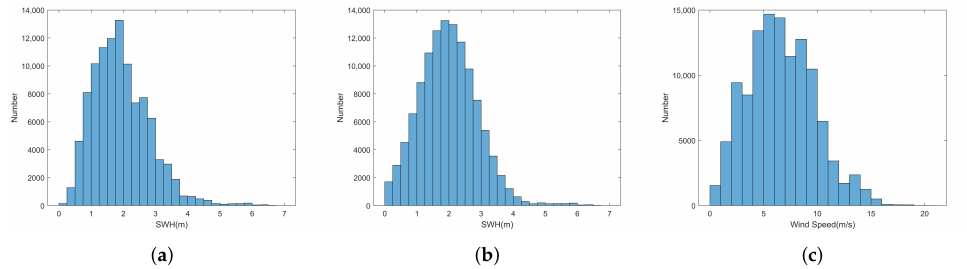
Figure 6. Histograms of the collocated data for training. ( a ) original SWH; ( b ) re-sampled SWH; ( c ) re-sampled wind